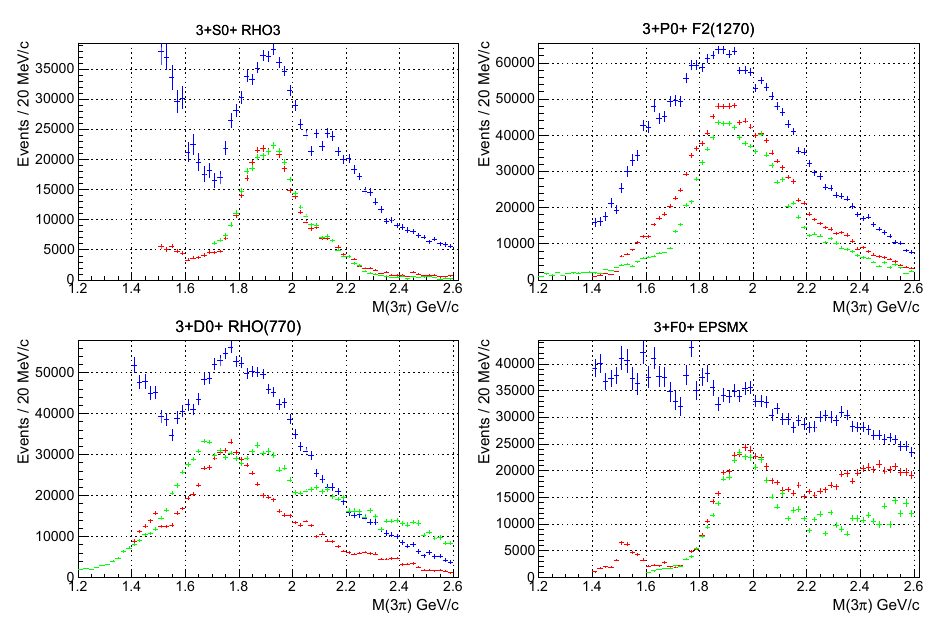
Figure 2. For the system π + 2 π − intensities of waves a) 3 + S 0 + ρ 3 (1690) π b) 3 + P 0 + f 2 (1270) π c) 3 + D 0 + ρ (770) π d) 3 + F 0 + επ